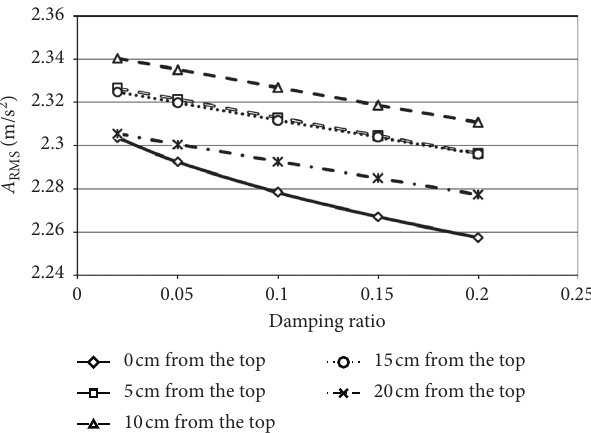
Figure 6: The effects of the damping ratio on vibration reduction (at monitored point A; damping layer thickness � 10mm).